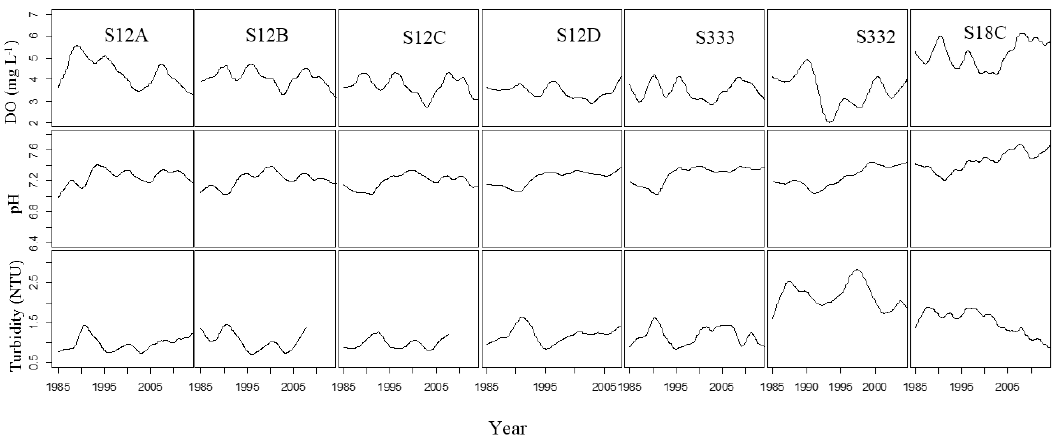
Figure 2. Trend changes of DO, pH, and turbidity at seven stations.